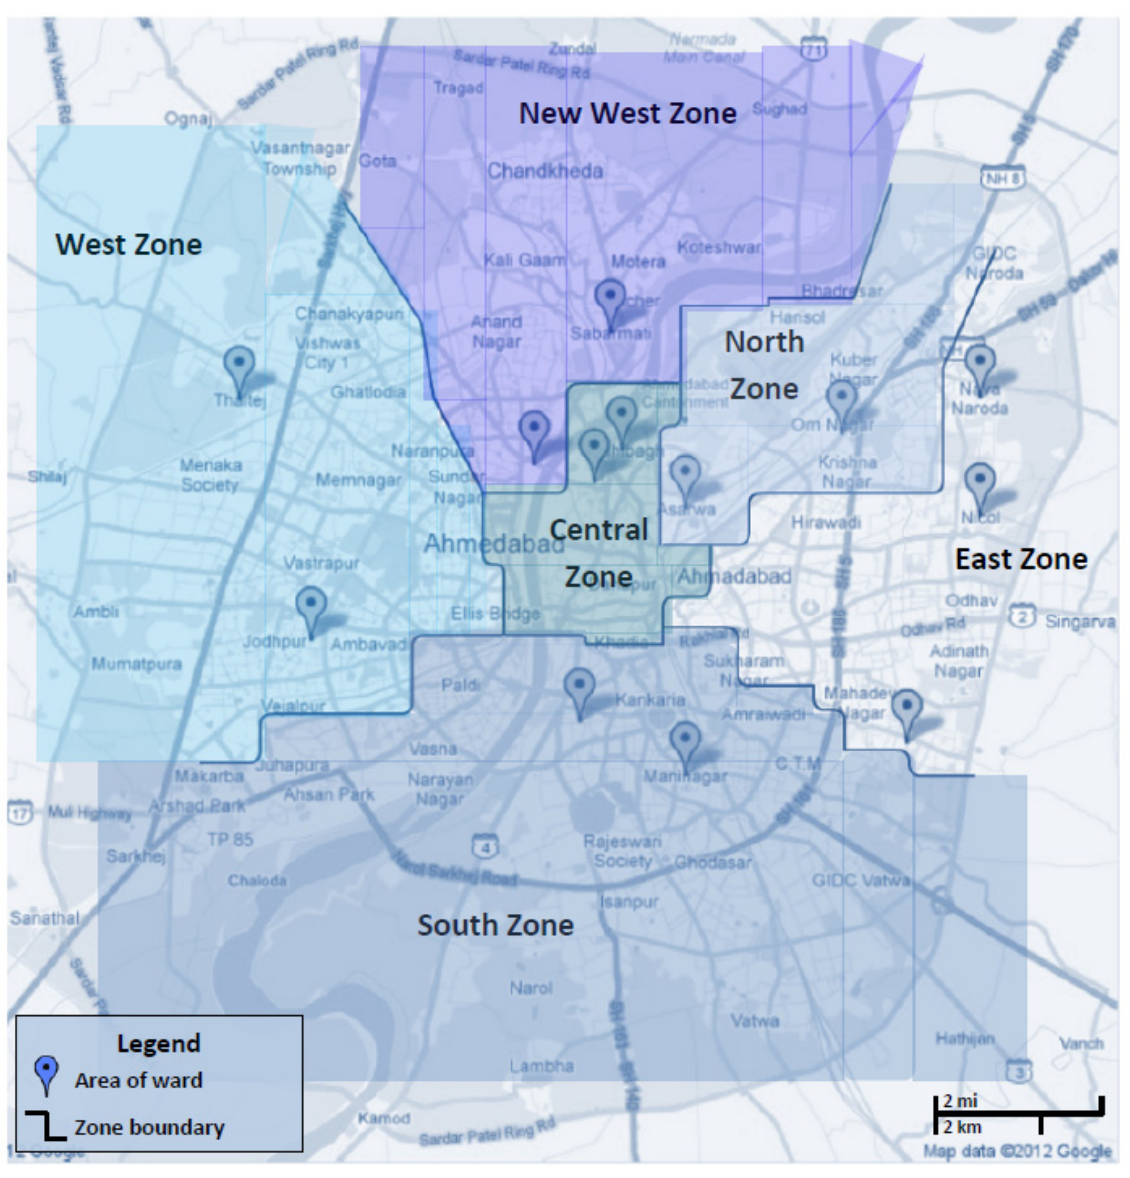
Figure 2. Location of 13 randomly selected wards. Markers represent the central location of the sampled wards as a GPS was not accessible. Two wards per zone were sampled in each of five zones (West, New West, South, Central, North); and three wards were sampled in a sixth zone (East). West zone: Sabarmati, Juna Vadaj; New West zone: Thaltej, Johdpur; South zone: Maninagar, Behrampura; Central zone: Madhupura, Dudeshwar; North zone: Saijpur, Asarwa; East zone: Nikol, New Naroda,